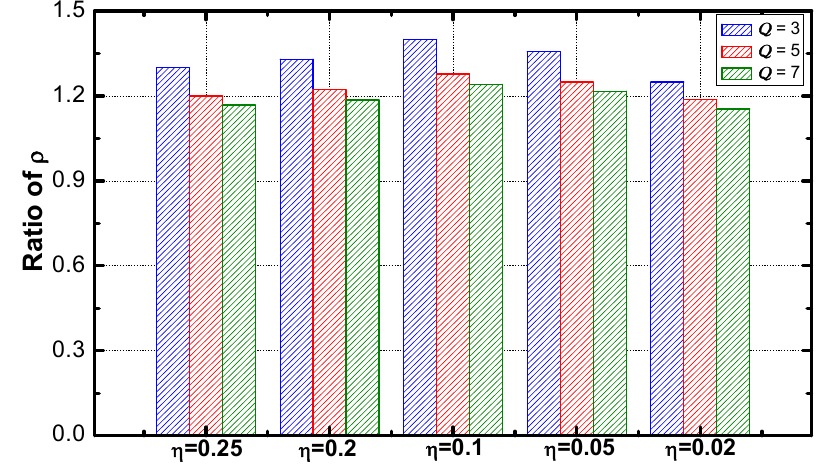
Figure 10. Average (cid:2025) in the network with different (cid:2015) . Figure 10. Average ρ in the network with different η